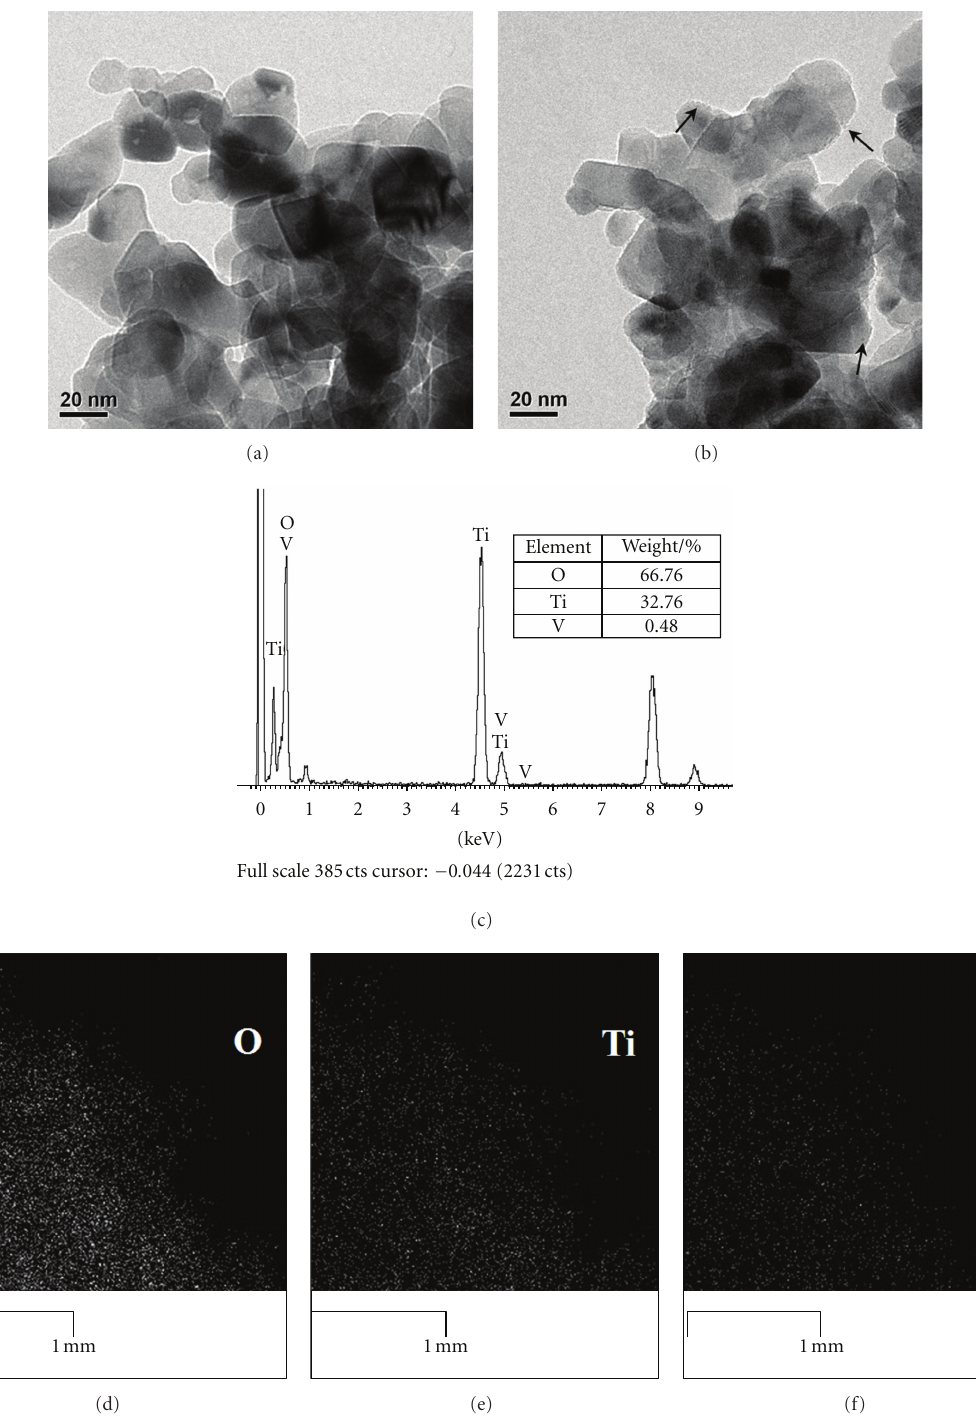
Figure 3: TEM image of N-doped TiO 2 sample (a), TEM image (b), EDS (c) and elemental mapping image (d, e, f) of of N-TiO 2 /V 2 O 5 -0.5%